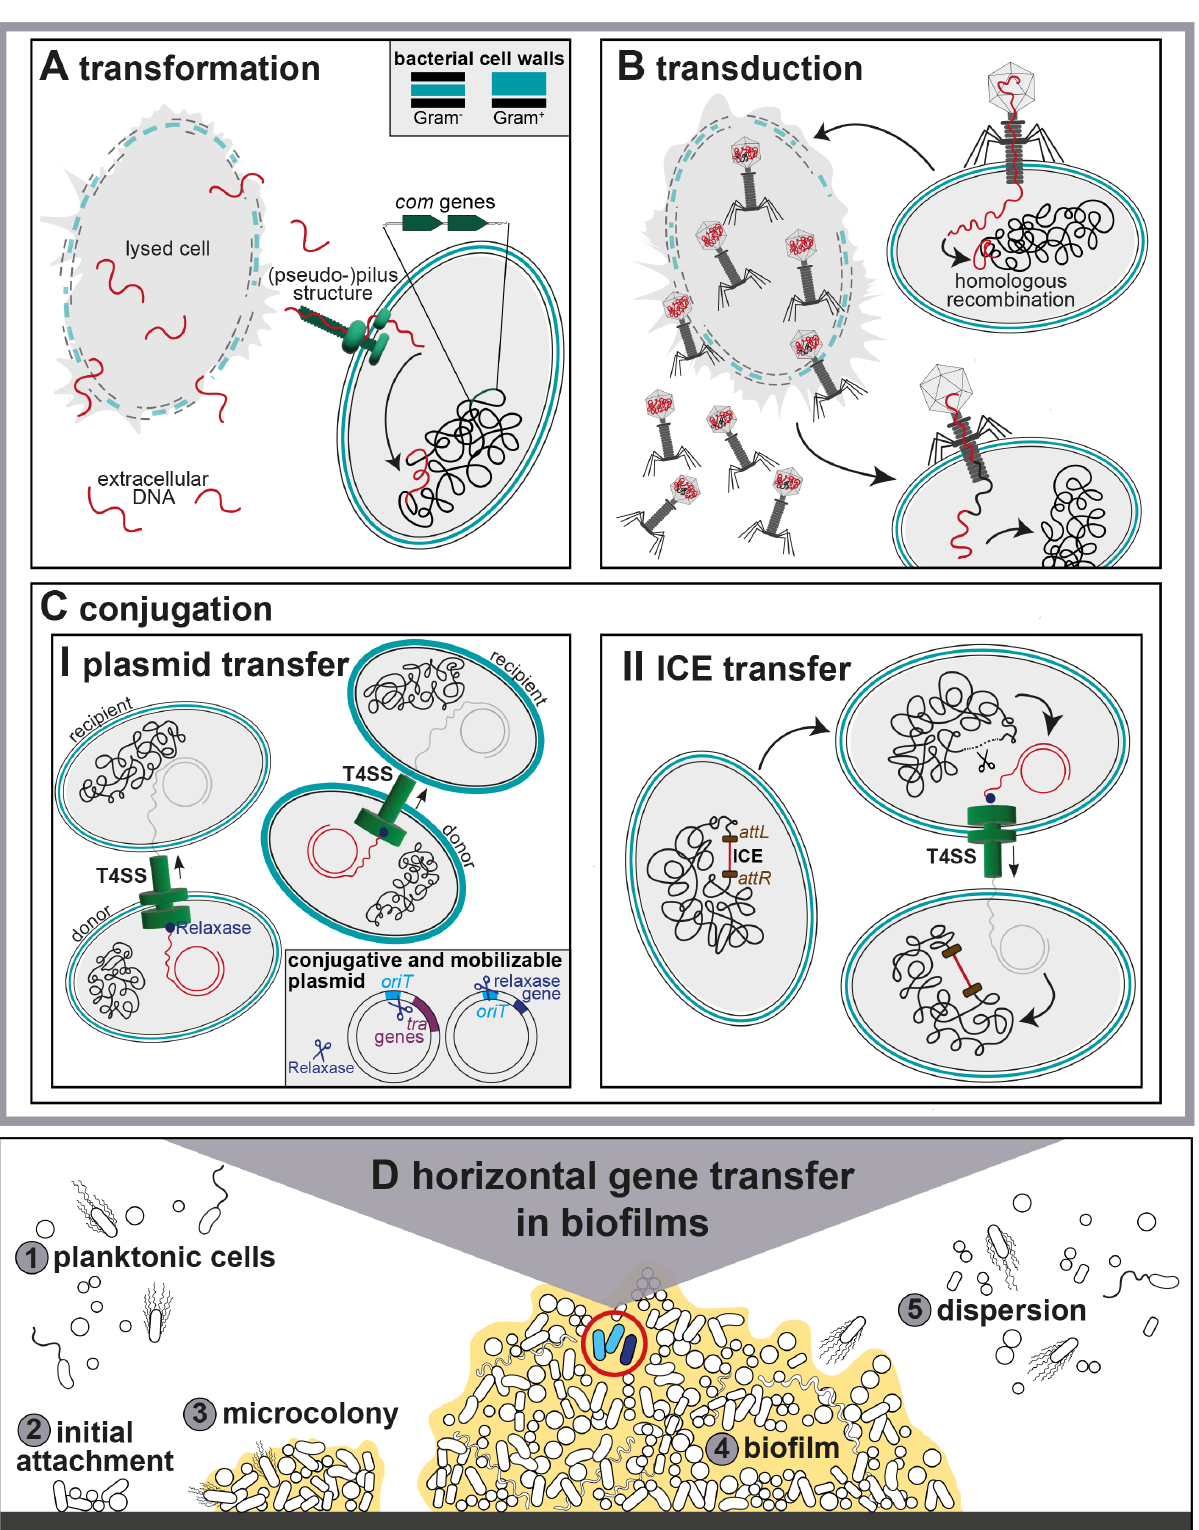
Figure 1. Horizontal gene transfer in polymicrobial biofilms. The upper panels A – C show the three main HGT mechanisms ( A ) Transformation, ( B ) Transduction and ( C ) Conjugation. Transferred,